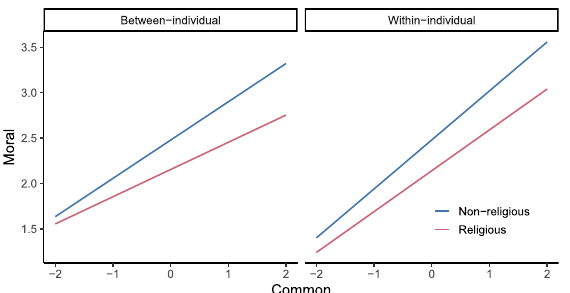
Fig. 8 Country differences in religiosity partly explain country differences in the strength of the common-is-moral association. The scatter plots show country-level religiosity plotted against country-level estimates of the within-individual common-is-moral association (left) and the between- individual common-is-moral association averaged across behaviours (right).